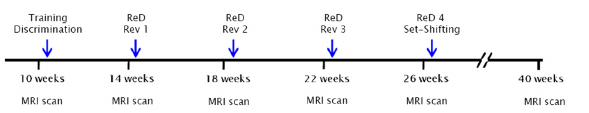
arrows indicate the cognitive tests that started a week after each MRI scan. All 23 animals (11 controls and 12 SHR) underwent the MRI scans. Of those same animals, 16 (8 control and 8 SHR) performed the behavioral